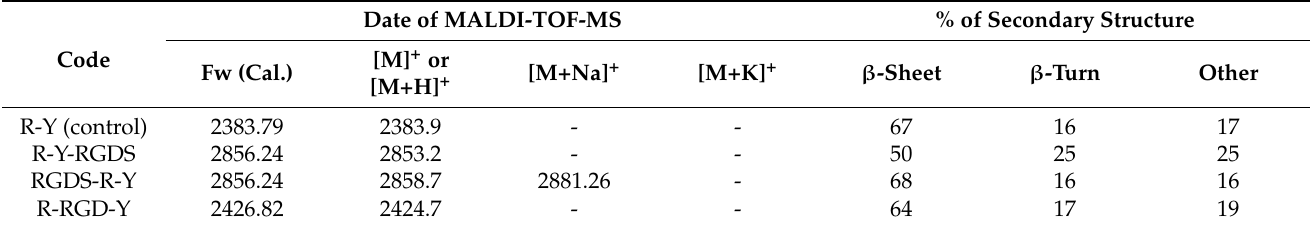
Table 2. Results of MALDI-TOF MS spectra analysis and secondary structure analysis of synthetic peptide by FT-IR spectra.